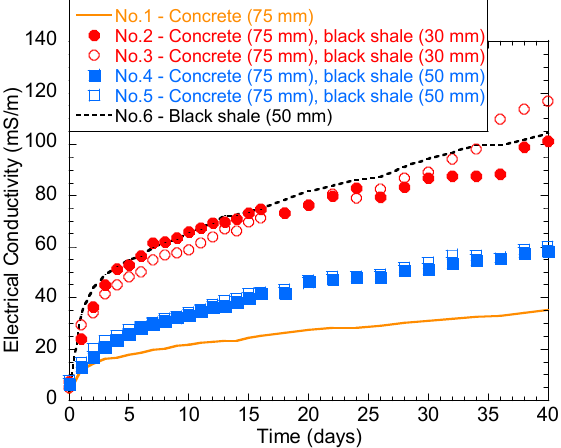
Figure 4. Temporal behavior of the solution electrical conductivity (EC) during the laboratory immersion tests.